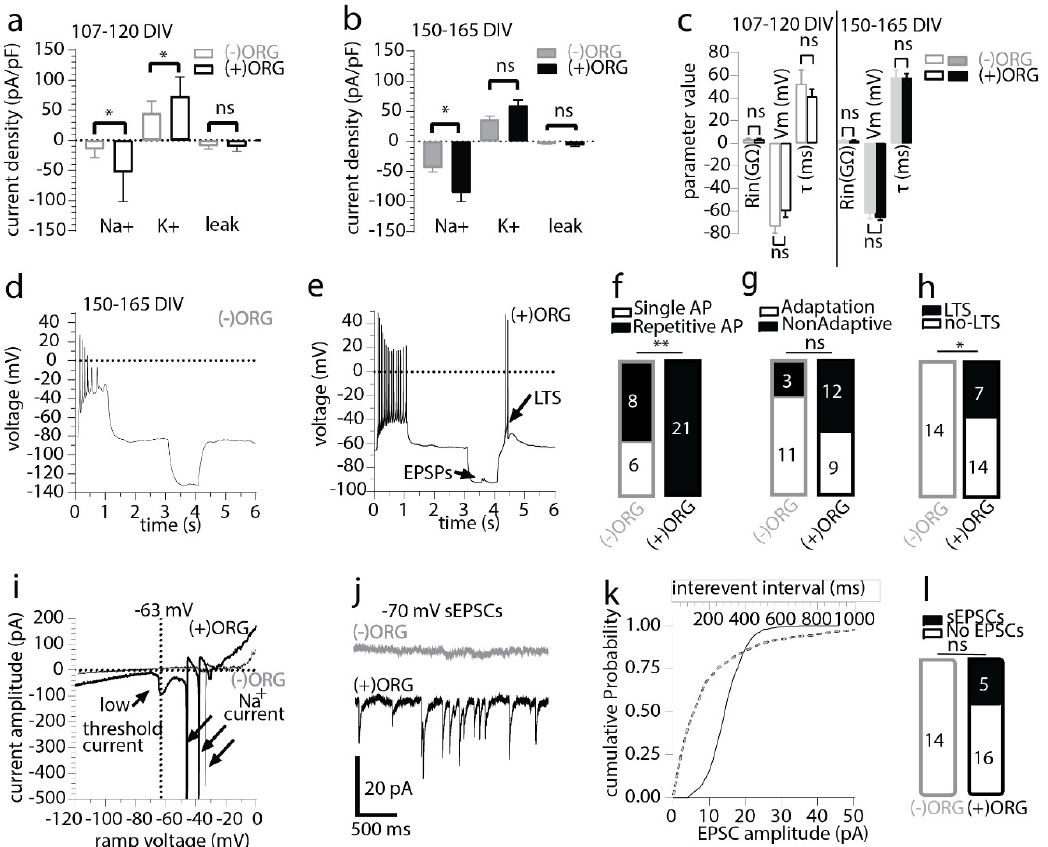
Figure 3. Incorporated IBA1+ population supports neuronal maturation and synaptic signalling in cerebral organoids. ( a ) Maximal sodium, potassium, and leak, current density in 107–120 day old organoids. n = 8 vs. 9 neurons (mean ± SEM; Mann–Whitney unpaired test, * p < 0.05, ns-non-signif-